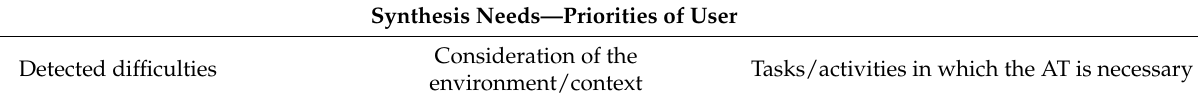
Table 1. Factors considered for the design of Low-Cost Assistive